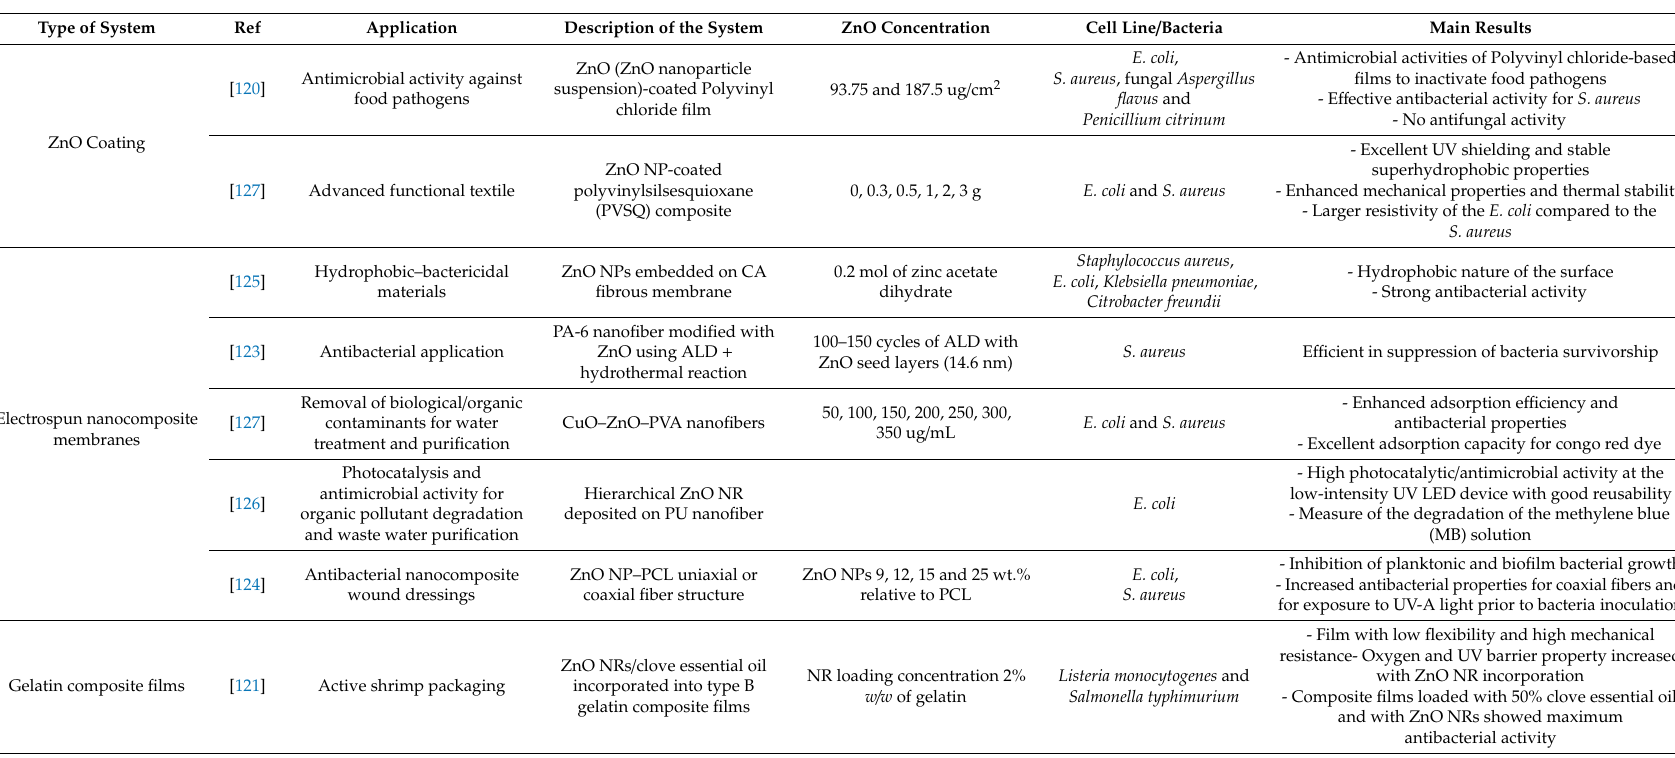
Table 4. Main results of recent studies on ZnO-based nanomaterials and ZnO–polymeric composite nanomaterials for sustainability